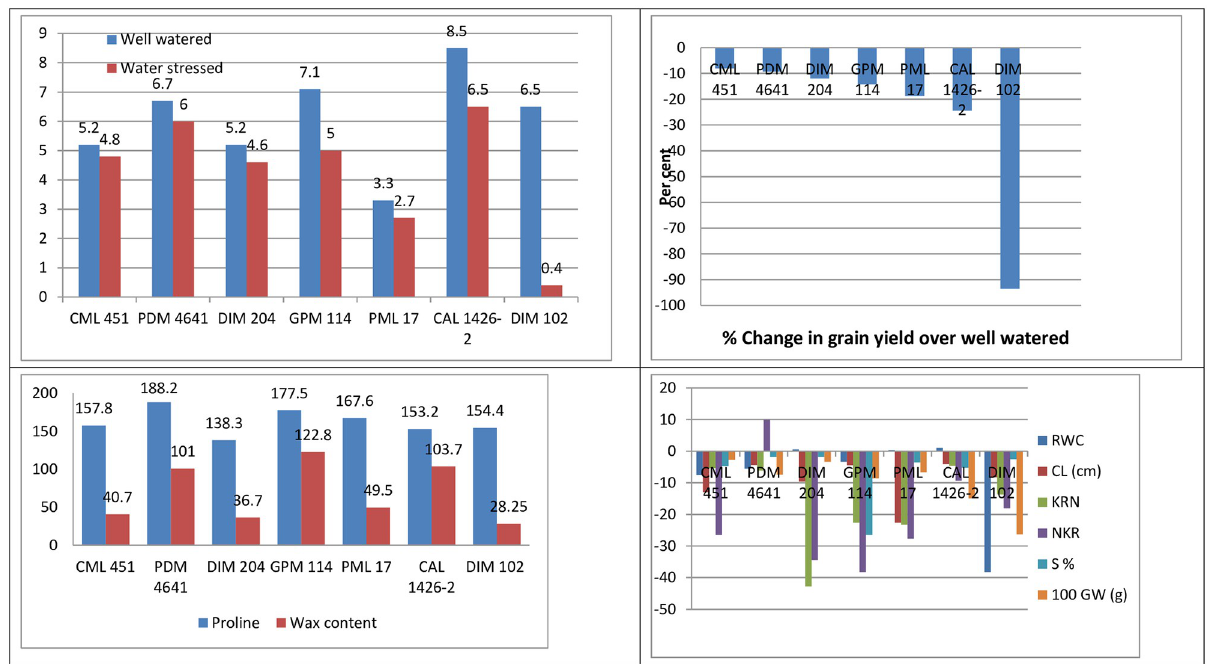
Fig 2. Per se performance of drought tolerant genotypes for grain yield (tha -1 ) and per cent change over well watered for yield, yield components and physiological parameters.